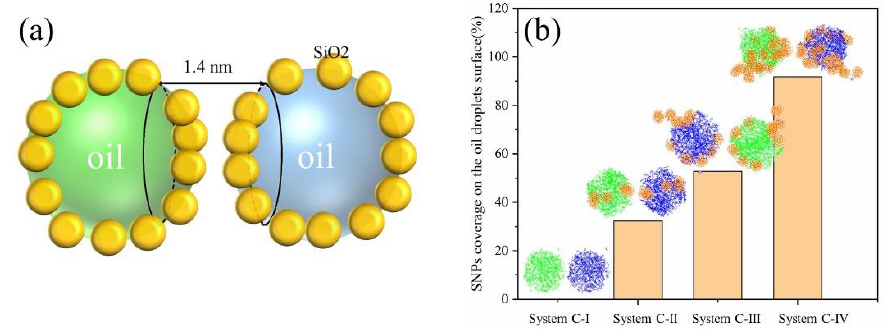
Figure 9. Schematic of SNPs within 1.4 nm of the adjacent interface between two oil droplets ( a ). The coverage of SNPs on the surface of oil droplets for four systems ( b